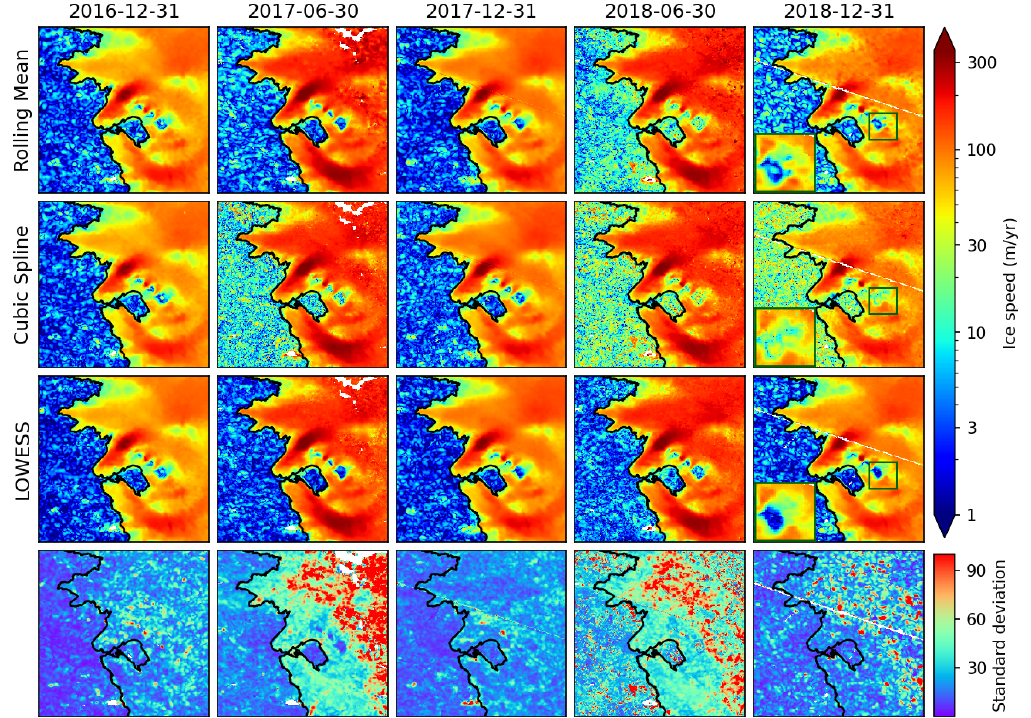
Figure 10. (Three top rows) Ice speeds for selected dates obtained by the different statistical and regression methods (3-weeks window for Rolling Mean and 2 weeks averaging for regressions). The right column sub-panel is a zoom-in for a nunatak area. Color coding is on logarithmic scale from blue ( < 1 m/yr) to red ( > 300 m/yr). (Bottom row) Standard deviation of the ice speed measurements for the combined dataset computed over an interval of 2 weeks for the shown dates. Maps are displayed in north polar stereographic projection and the area of the cube is 37.5 × 37.5 km. The black line corresponding to the ice margins delimits the boundary between ice-free (left) and ice-covered (right)